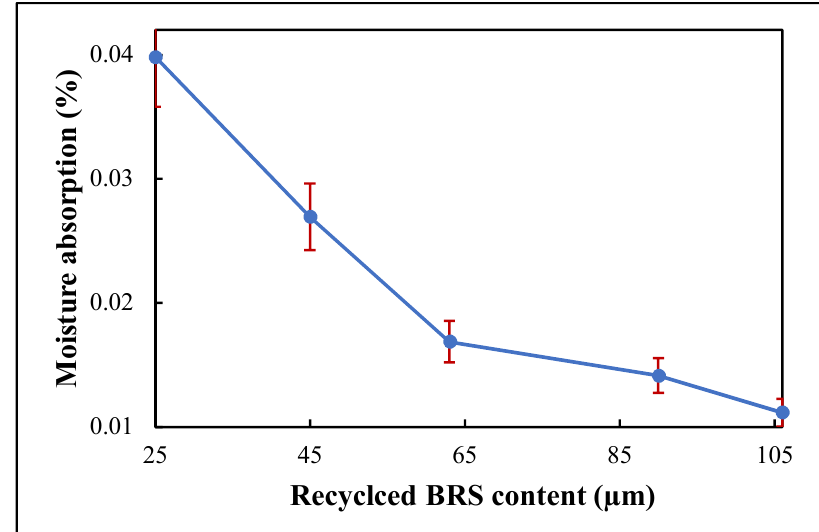
Figure 5. Variation of moisture absorption with filler size.